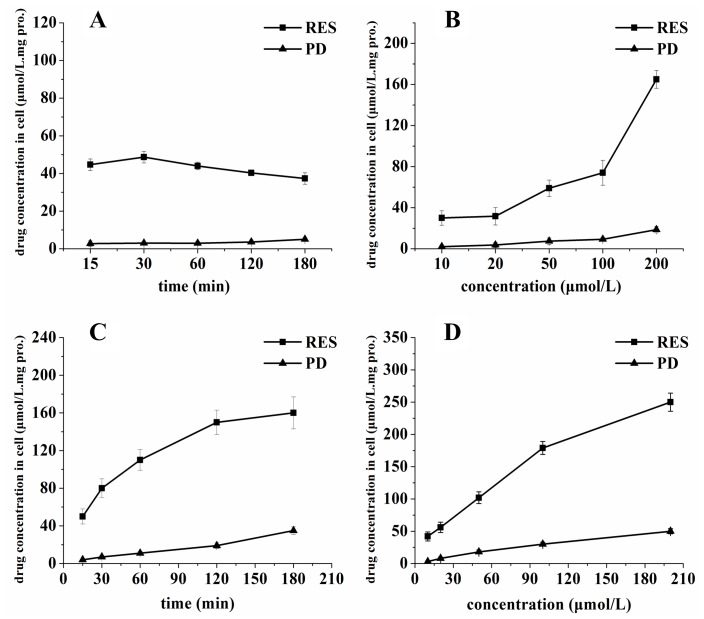
The quantitative uptake curve of resveratrol (RES) and piceid (PD) after incubated with HepG2 cells (A and B) and MDA-MB-231 cells (C and D).Panel A and panel C show the time course uptake of RES and PD at the concentration of 15 µmol/L, Panel B and panel D show concentration-dependent uptake of RES and PD in 30 min.